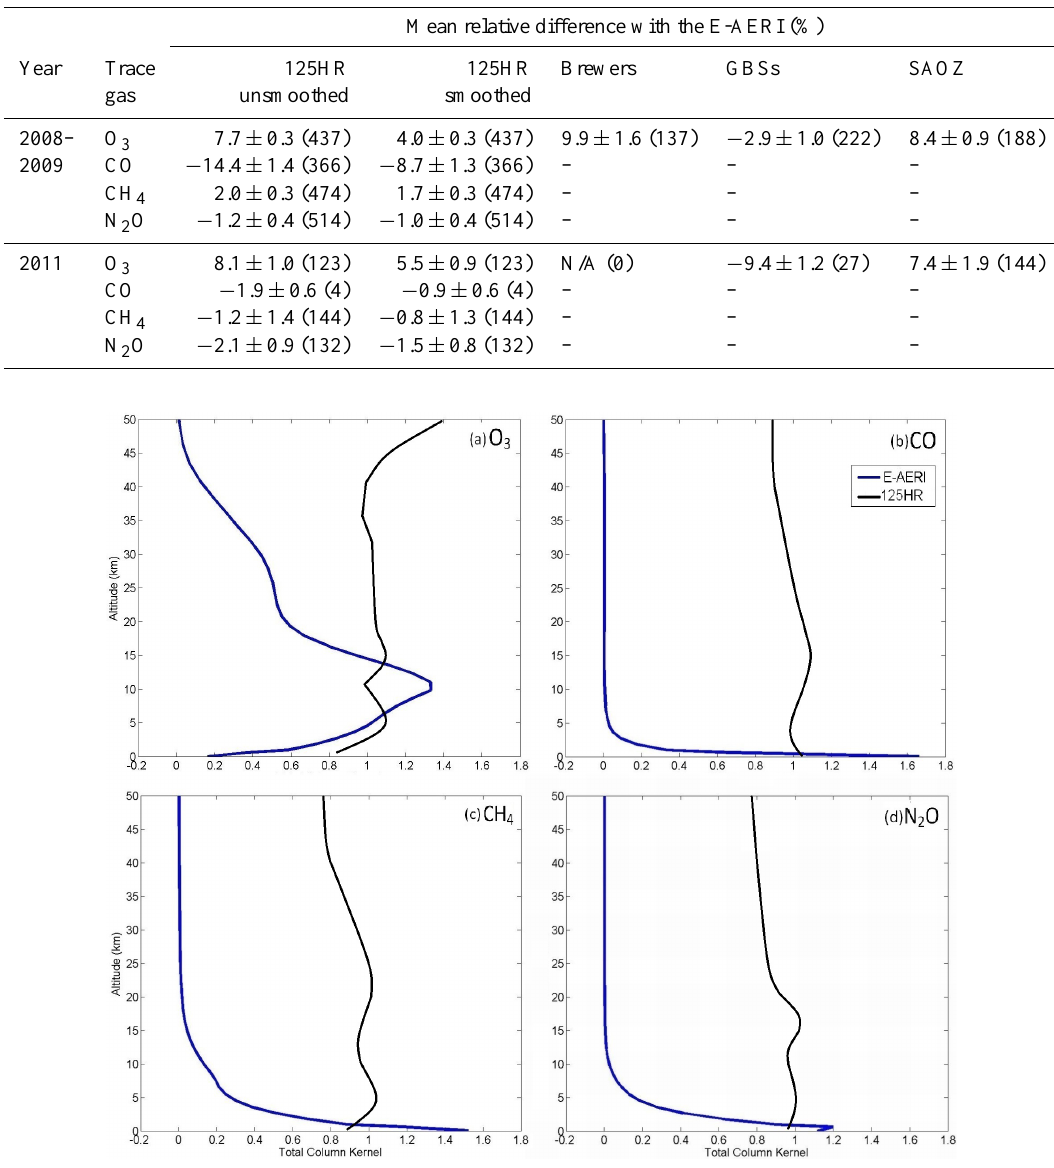
Fig. 4. Typical E-AERI (blue) and 125HR (black) total column averaging kernels (moleccm − 2 /moleccm − 2 ) in February for (a) O 3 , (b) CO, (c) CH 4 , (d) N 2